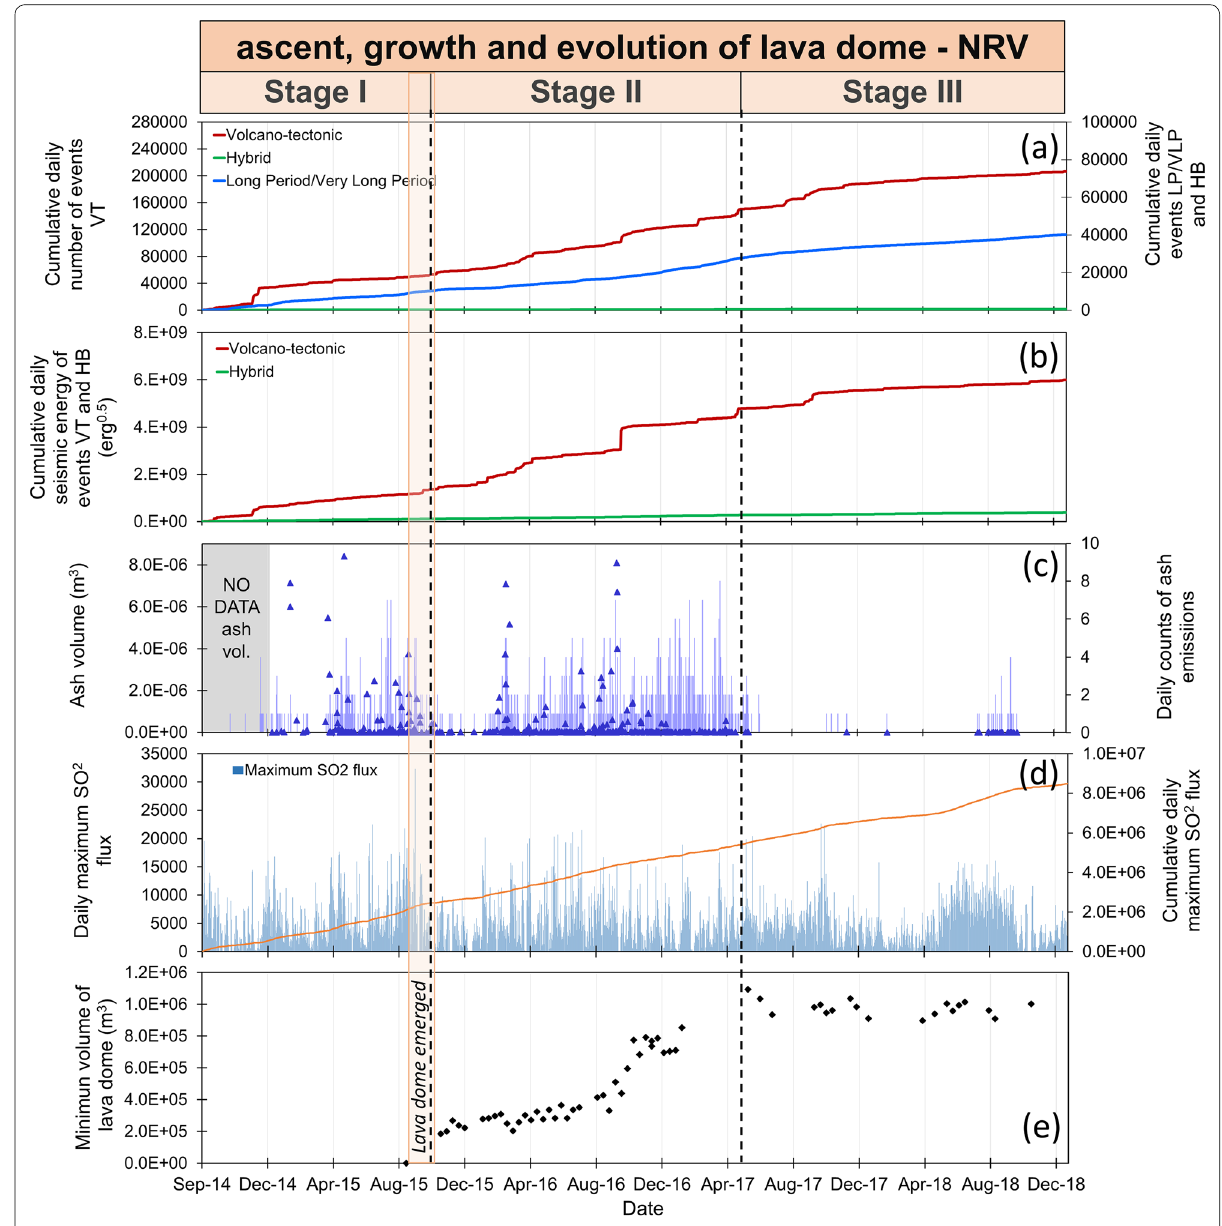
Fig. 2 A part of the volcano monitoring parameters at NRV taken by SGC‑OVSM. a The cumulative numbers of volcano‑tectonic (VT) earthquakes (red), long‑period (LP) or very‑long‑period (VLP) events (blue), and hybrid (HB) ones (green). b The cumulative energy of VT (red) and HB (green) events. c Ash volume for the reported eruptions (triangles) obtained by (Londono and Galvis, 2018) and daily counts of ash emission events (bars) from SGC‑OVSM catalog. d The daily maximum SO 2 flux (blue bars) and its cumulative values